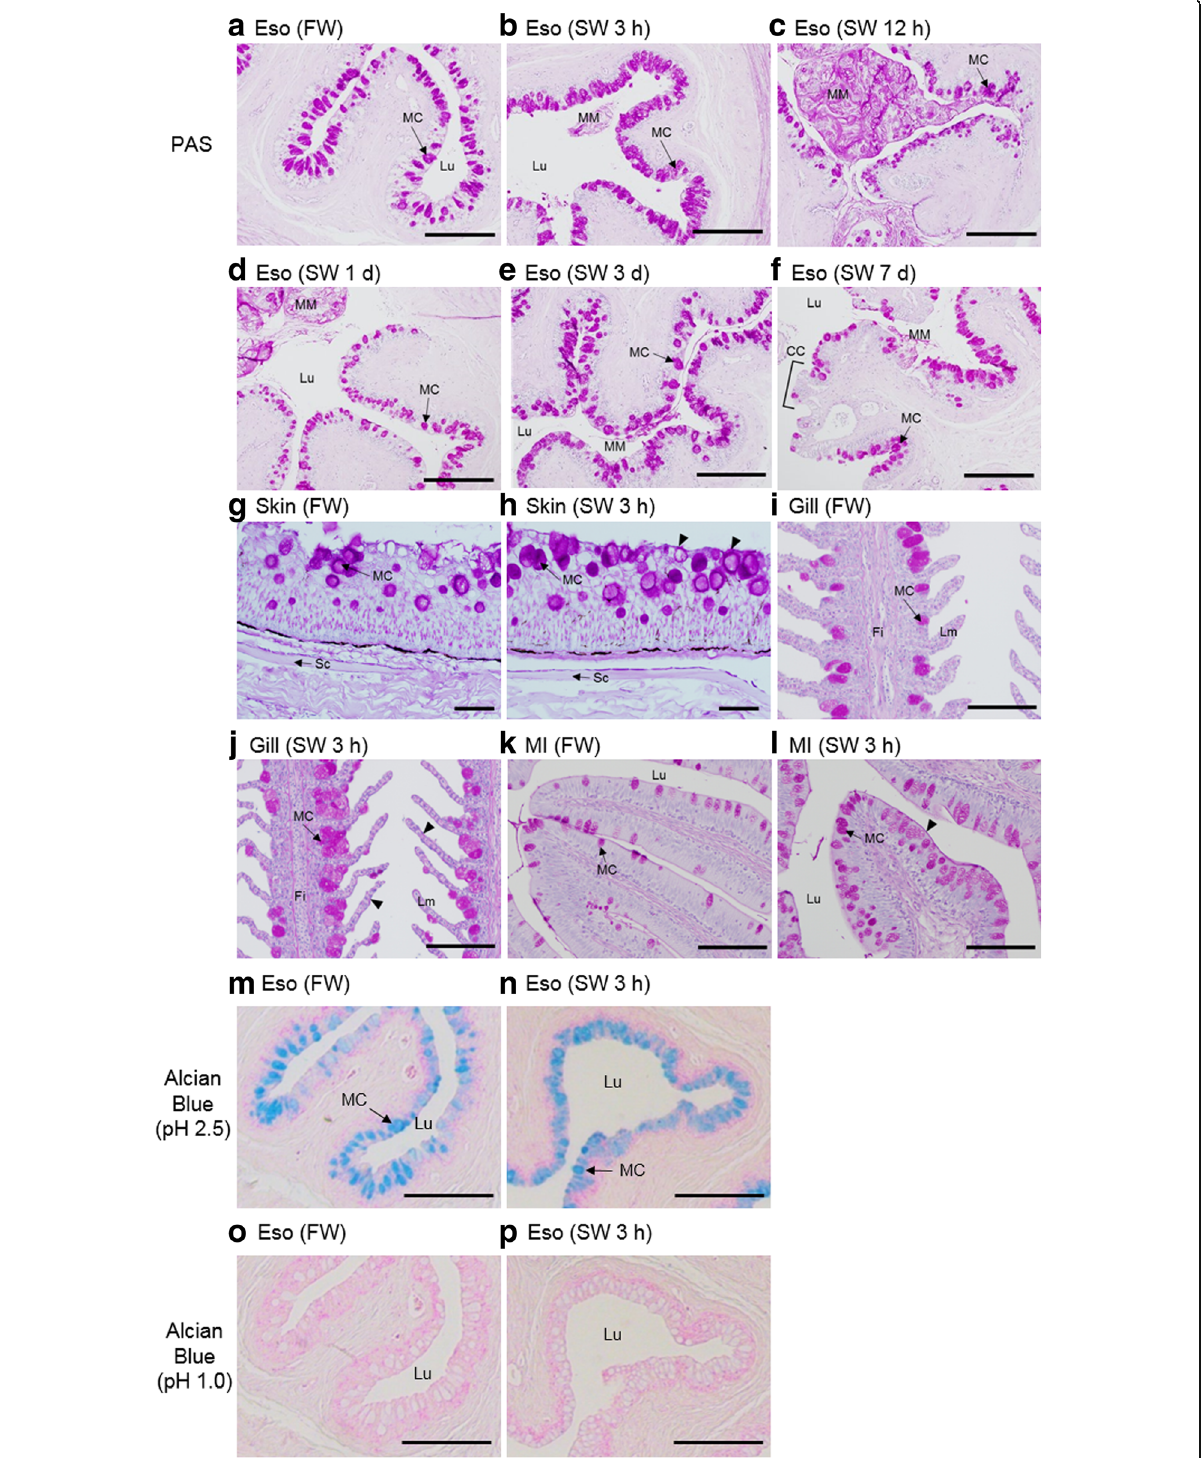
Fig. 4 Periodic acid – Schiff (PAS), Alcian blue stainings of esophagus (Eso), skin, gill, and middle intestine (MI) of eels acclimated to FW ( a , g , i , k , m , o ) or SW after 3 h ( b , h , j , l , n , p ), 12 h ( c ), 1 d ( d ), 3 d ( e ) 7 d ( f ). PAS- and Alcian blue (pH 2.5)-positive mucus cell (MC) density increased rapidly 3 h after SW transfer in Eso. Alcian blue (pH 1.0) staining was negative in the esophageal epithelia. Mucus mass (MM) with desquamated cells are prominent in the lumen (Lu) during early transfer (from SW 3 h – SW 1 d) in Eso. Absorptive columnar cells (CC) are present on the esophageal villi after 7 d in SW. Arrow heads indicate the mucus layer thickening after SW transfer. Sc = scale; Fi = filament; Lm = lamellae. Scale bar = 200 μ